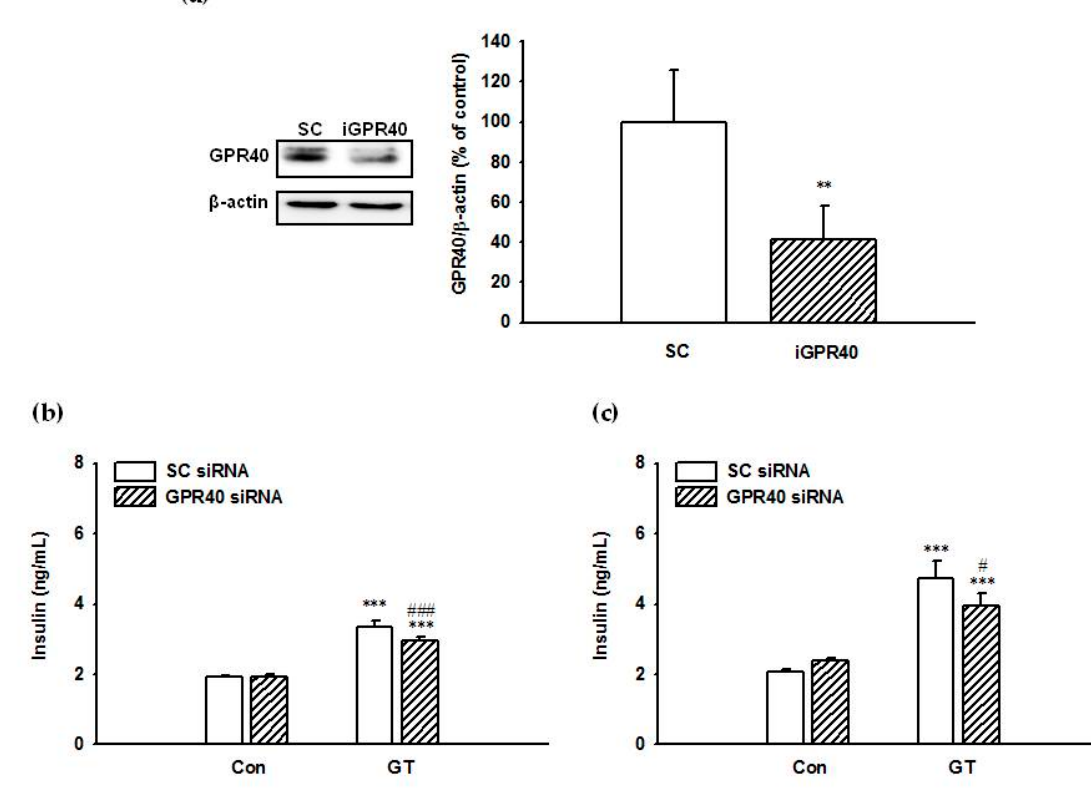
Figure 3. E ff ect of siRNA treatment on GPR40 expression ( a ) and gintonin-induced insulin secretion ( b ), ( c ) in INS-1 cells. INS-1 cells were transfected with either scrambled siRNA (SC) or GPR40 siRNA (iGPR40) and incubated for 3 days. ( a ) Immunoblot analysis of GPR40 levels in INS-1 cells transfected with either scrambled siRNA (SC) or GPR40 siRNA. Data represent means ± SD ( n = 4); ** p < 0.01, vs. sc siRNA. ( b ), ( c ) Transfected INS-1 cells were incubated with or without gintonin (30 µ g / mL) in KRB bu ff er (3.3 mM glucose ( b ) or 16.7 mM glucose ( c )) for 2 h. Insulin secretion was